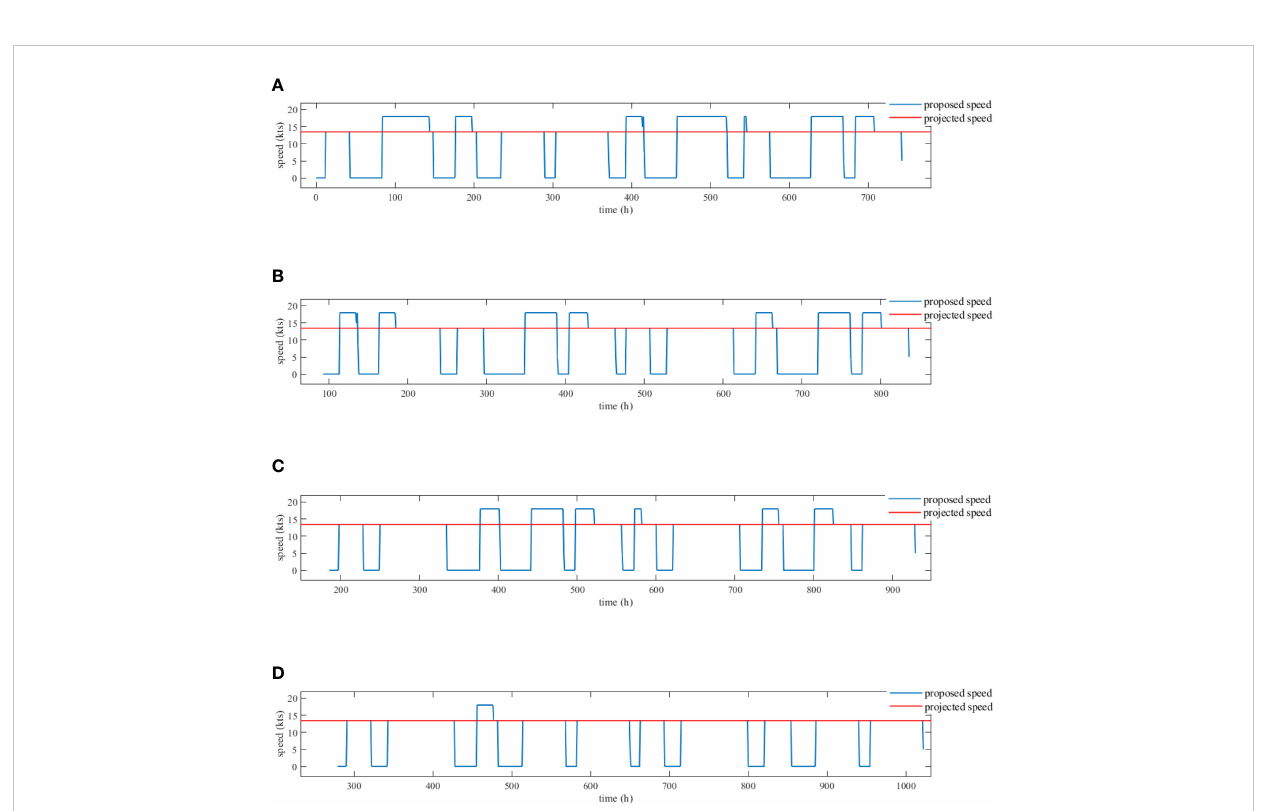
FIGURE 9 Speed of each ship under Reference 2: (A) ship 1; (B) ship 2; (C) ship 3; (D) ship